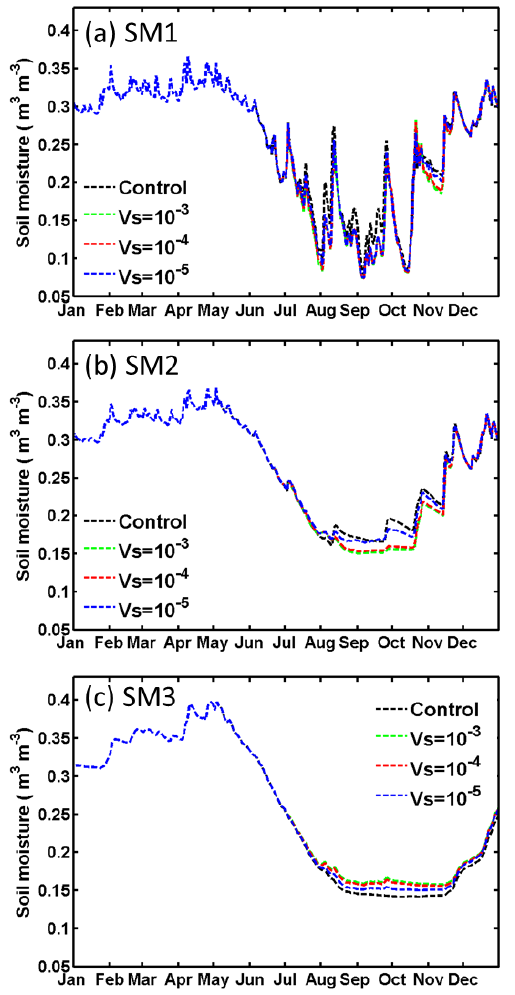
Figure 10. Same as Fig. 9, but SLR = 50% for the HAPEX case at depths of (a) SM1 (0–20cm), (b) SM2 (20–50cm) and (c) SM3